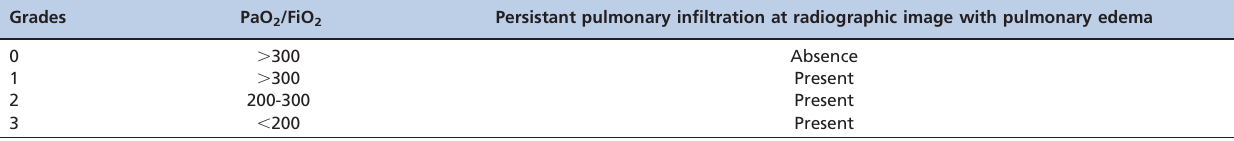
Table 1 - Classification of Primary graft dysfunction - Adapted from ISHLT (International Society of Heart and Lung Transplantation Registries)